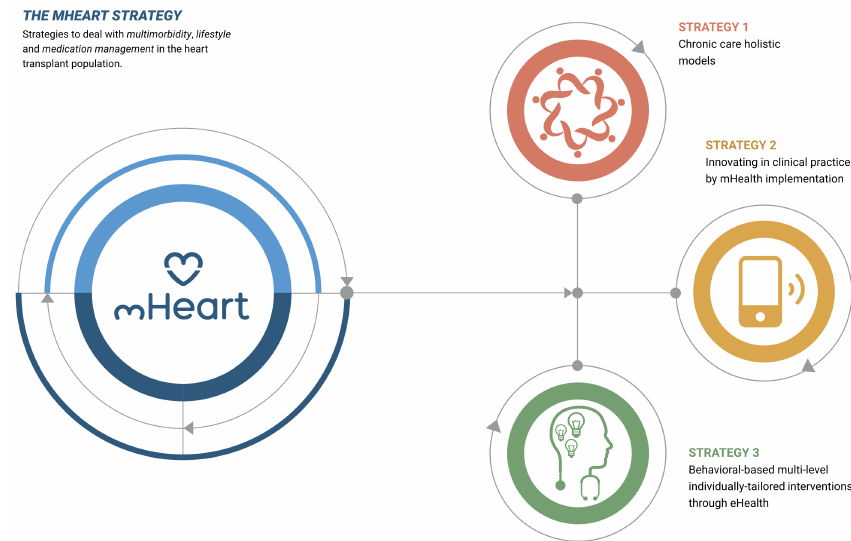
Figure 2. The mHeart strategy components. The strategy definition and design has been published in the pilot study [34], a summary is also provided in Supplementary File